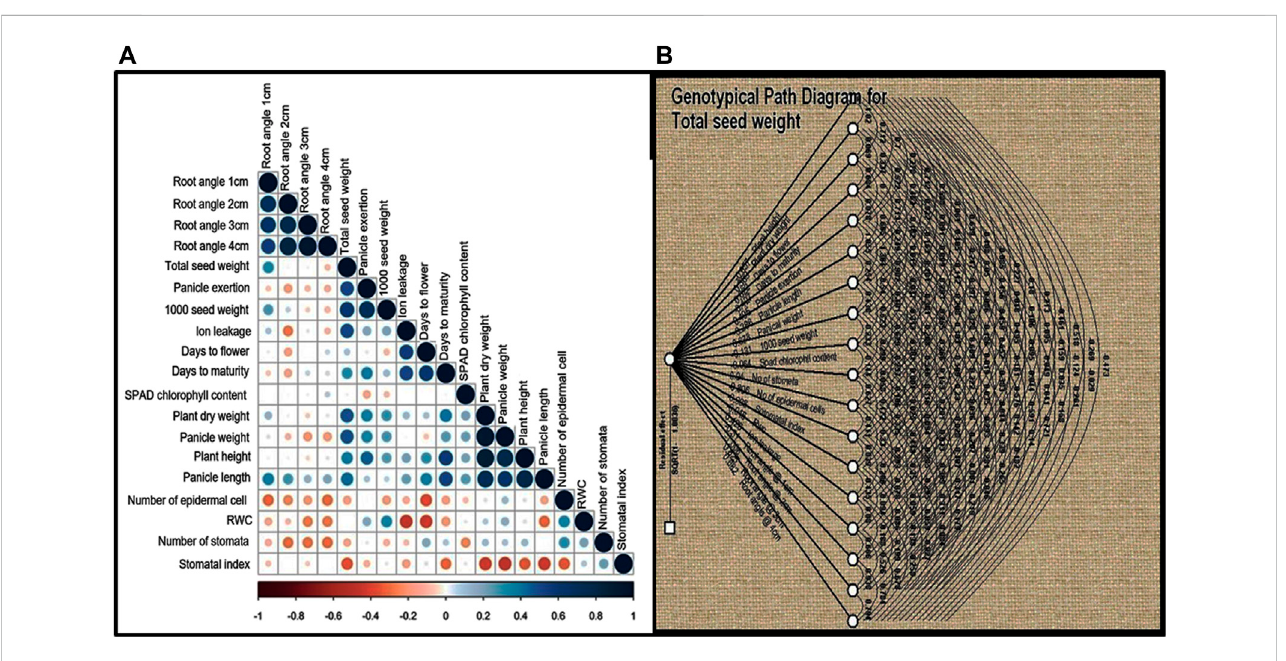
FIGURE 3 (A) Correlation analysis was performed for 19 quantitative traits for twenty foxtail millet landraces along with four released cultivars. Dark blue circles represents signi fi cant positive correlation, brown circles represents signi fi cant negative correlation and empty circles represent no signi fi cant